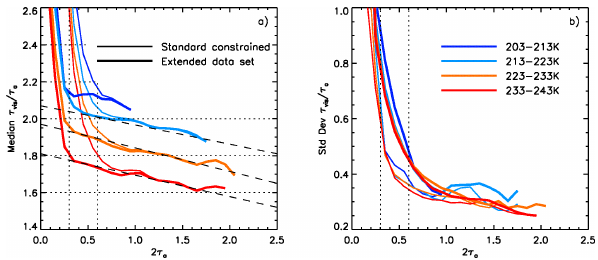
Figure 6. (a) Median τ vis / τ a ratio and (b) standard deviation from standard CALIOP constrained retrievals (thin lines) and from ex- tended CALIOP optical depth measurements (thick lines) for type 1 clouds retrieved from measured R BG after correction for cloud radiative temperature. The vertical dotted lines highlight the differ- ences for 2 τ a between 0.3 and 0.6 (see text). Same data set and color code as in Fig.